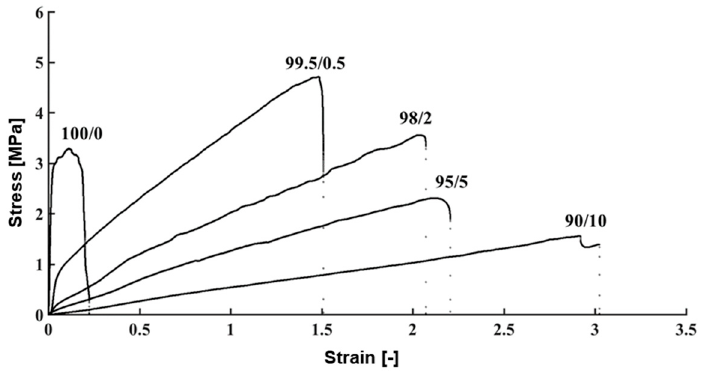
Table 2. Mechanical properties of Polydimethylsiloxane (PDMS) and Polyvinyl chloride (PVC)/Di-(2- ethylhexyl) phthalate (DEHP) used in this study to replicate sclera and trabecular meshwork tissues, respectively.